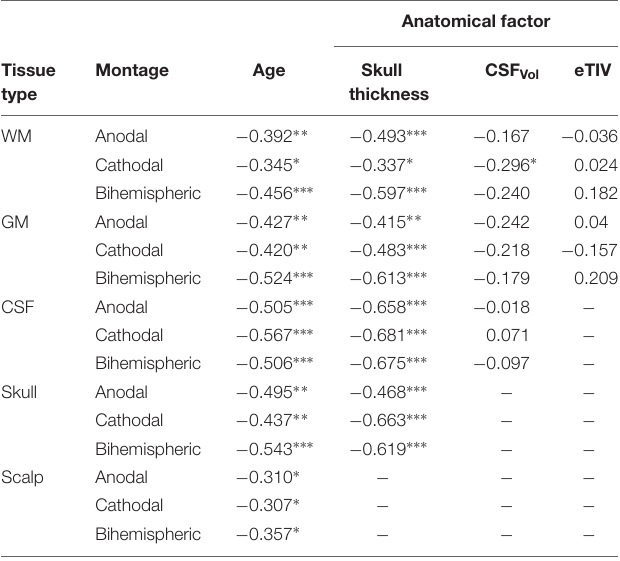
TABLE 2 | Correlations of PeakEF across tissue types.